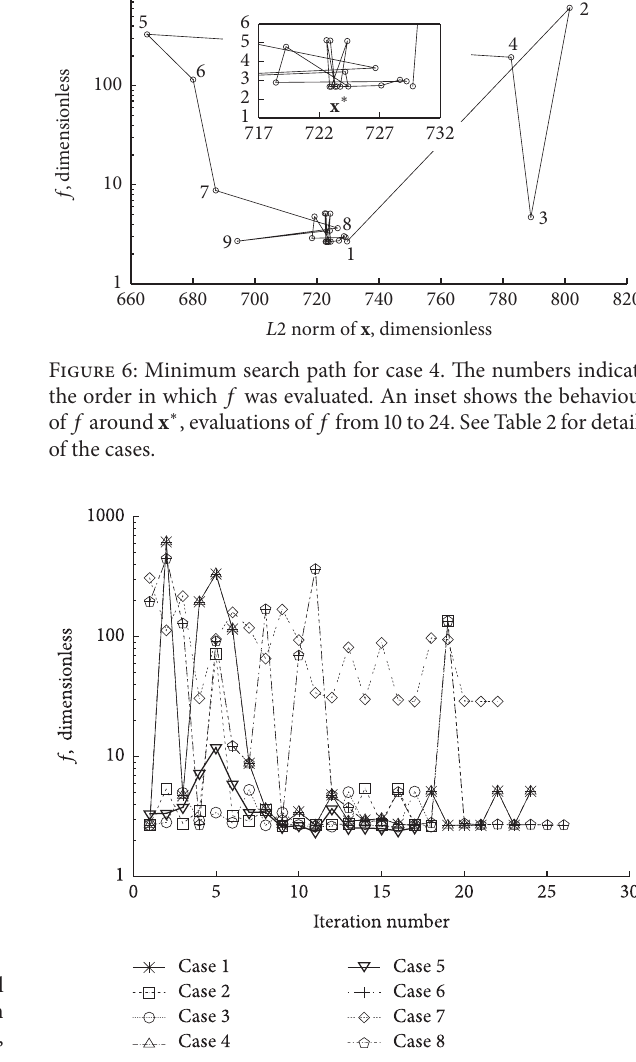
Figure 7: Rate of convergence for cases detailed in Table